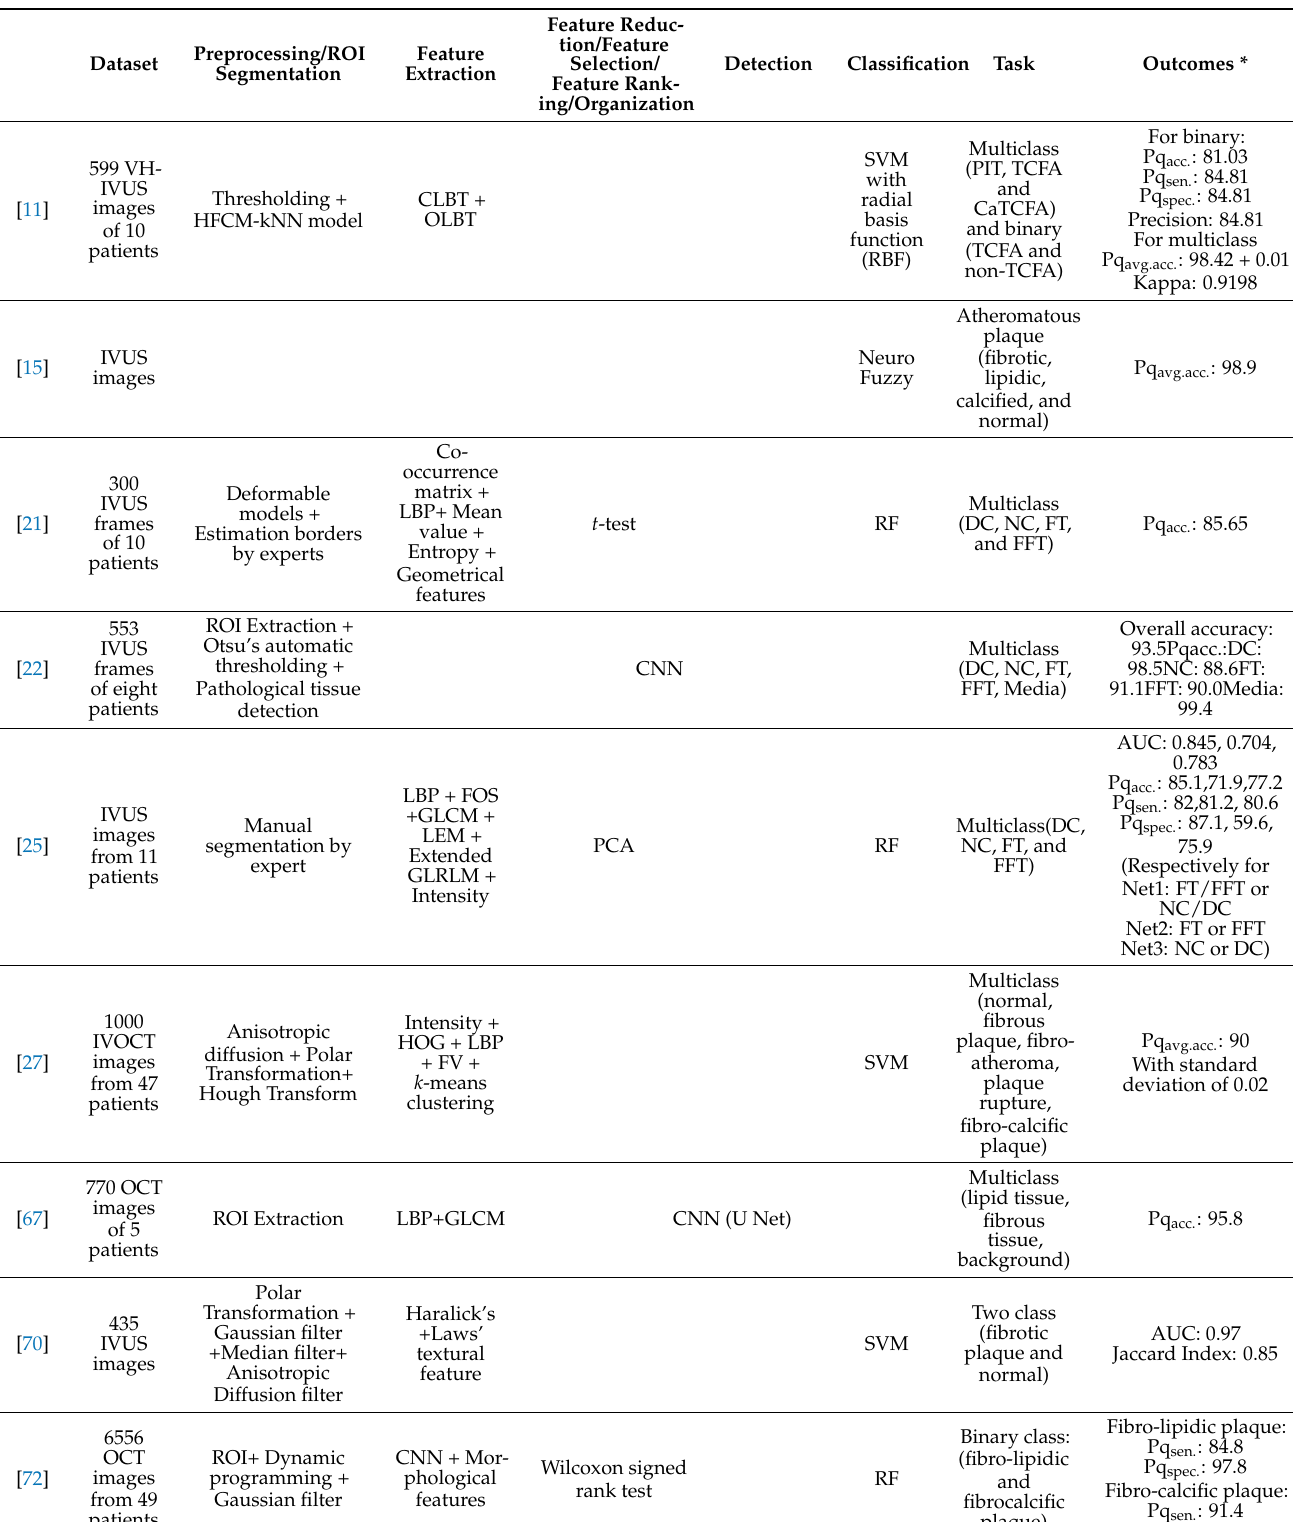
Table 1. Summary of various state-of-the-art techniques employed for plaque characterization using coronary artery scans.